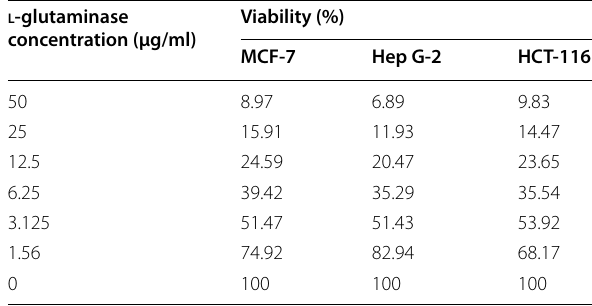
Table 3 Cytotoxicity activity of l -glutaminase produced by Bacillus sp. DV2-37 against human breast (MCF-7), hepatocellular (HepG2), and colon (HCT-116) carcinoma cells